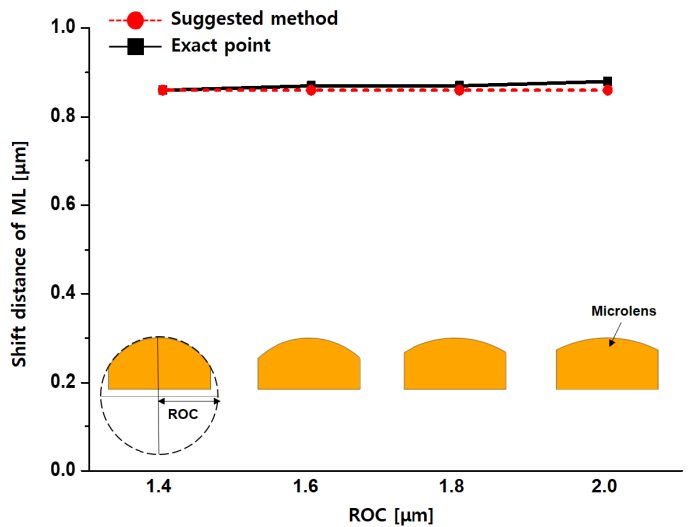
Figure 5. Comparison of simulation and calculation results with the changed microlens (ML) ROC from 1.4 to 2.0 μm on the same condition of pixel pitch and microlens height at CRA 35°.